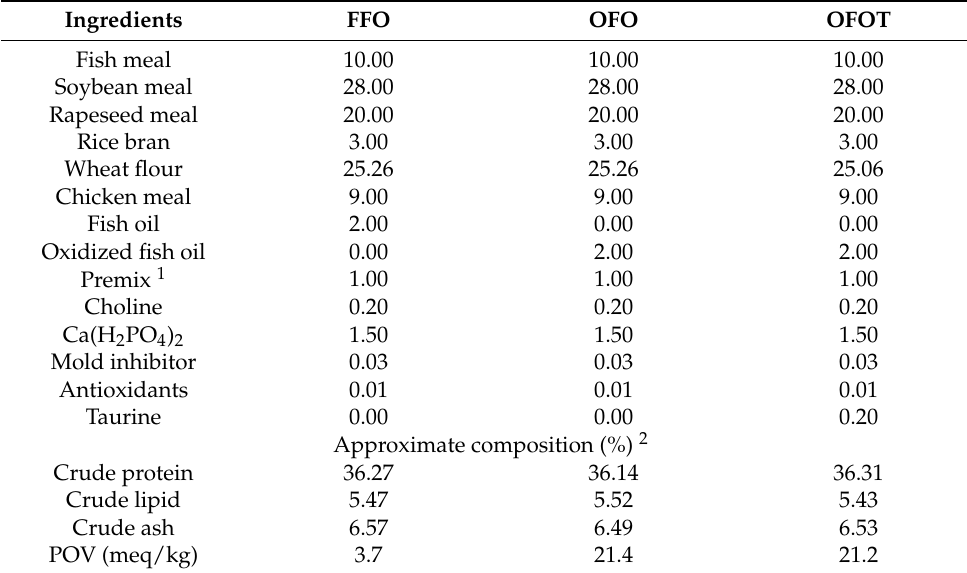
Table 1. Composition and nutrient levels of basic diet (%, dry